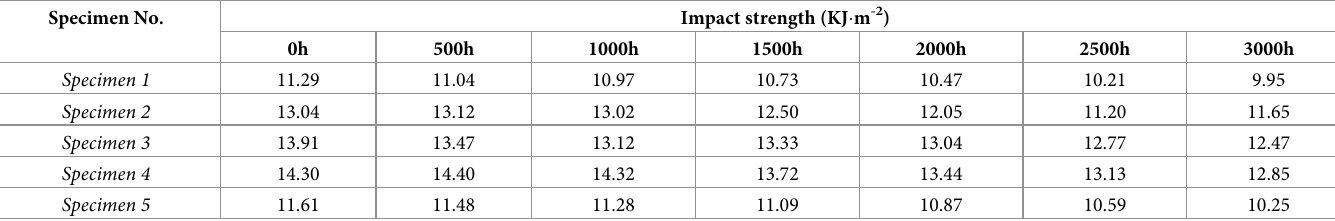
Table 6. Impact strengths before and after UV-accelerated aging. Specimen